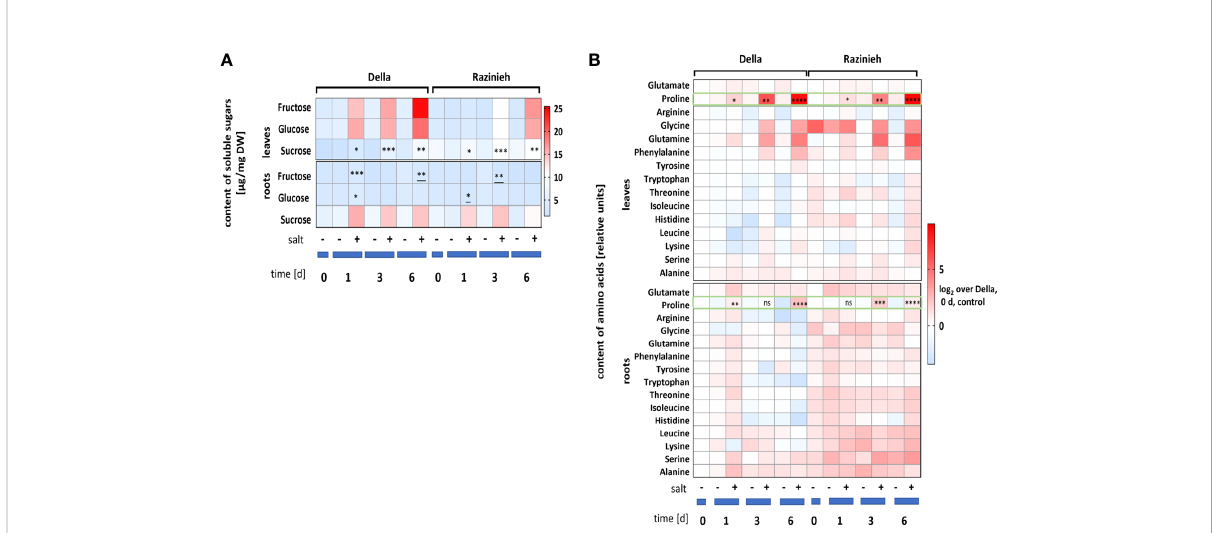
FIGURE 3 Metabolites abundance estimated in roots and 2 nd leaves in control and salt-stressed Della and Razinieh thirteen days old seedlings stressed in aqueous NaCl (100 mM) solution for 1, 3, 6 days. (A) absolute values of soluble sugars: glucose, fructose, and sucrose. (B) Log 2 ratios of mean amino acids abundance compared to the control of Della at day 0. Values represent the mean of at least three independent experiments ± SE. Asterisks indicate a statistically signi fi cant difference between treatment and corresponding control, as determined by Student ’ s t -test (* P < 0.05,